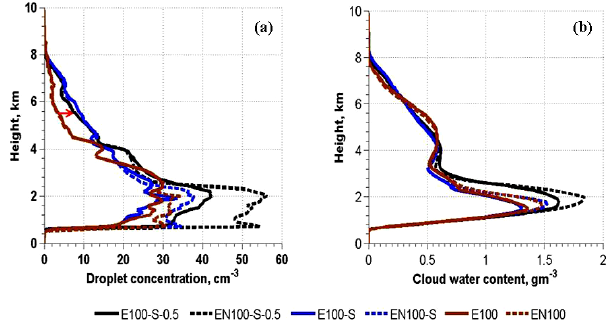
Figure 8. Vertical profiles of the maximum values of droplet con- centration (a) and CWC (b) in simulations with low CCN concen- tration ( N 0 = 100cm − 3 ). The profiles are obtained by averaging over the time period of 3420–4020s. The red arrow shows the in- crease in droplet concentration due to in-cloud nucleation in simu- lations with the CCN spectra containing small CCN.